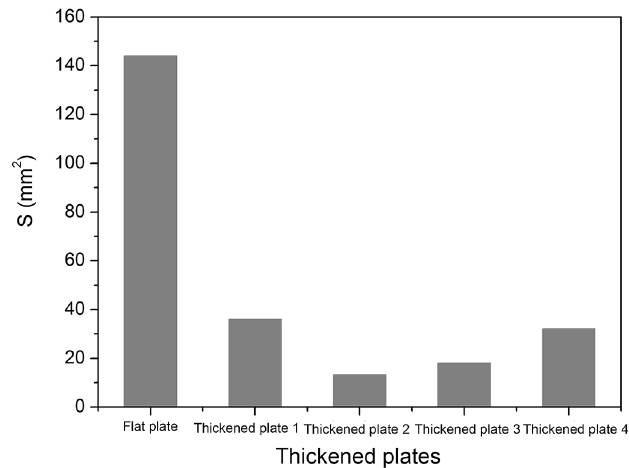
Fig. 19. The values of S with various – In the cup wall, the tangential residual stress exhibits a little change with an increase in blank holder forces and die corner radii. In the die entrance radius of square cup, the tangential residual stress exhibits a little change with an increase in die corner radii. – As opposed to fl at plates, using local-thickened plates can not only reduce the residual stresses values in hot stamped square cups, but also decrease the radius at the bottom corner of square cups. When the optimized thickening scheme of plate is used, the square cup with smaller radius at the bottom corner and lower residual stresses can be obtained.